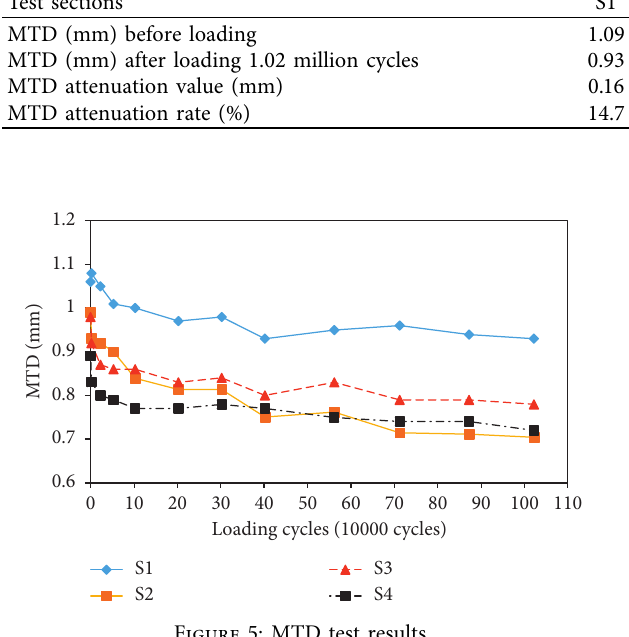
Figure 5: MTD test